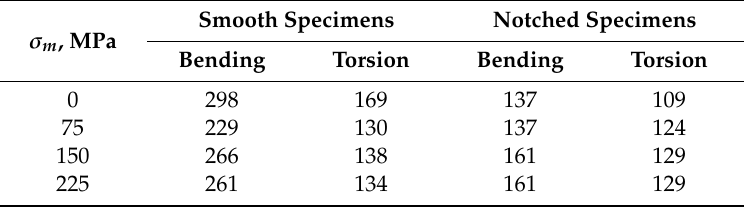
Table 5. Fatigue limits of smooth and notched specimens for di ff erent values of mean stress. Smooth Specimens Notched Specimens σ m , MPa Bending Torsion Bending